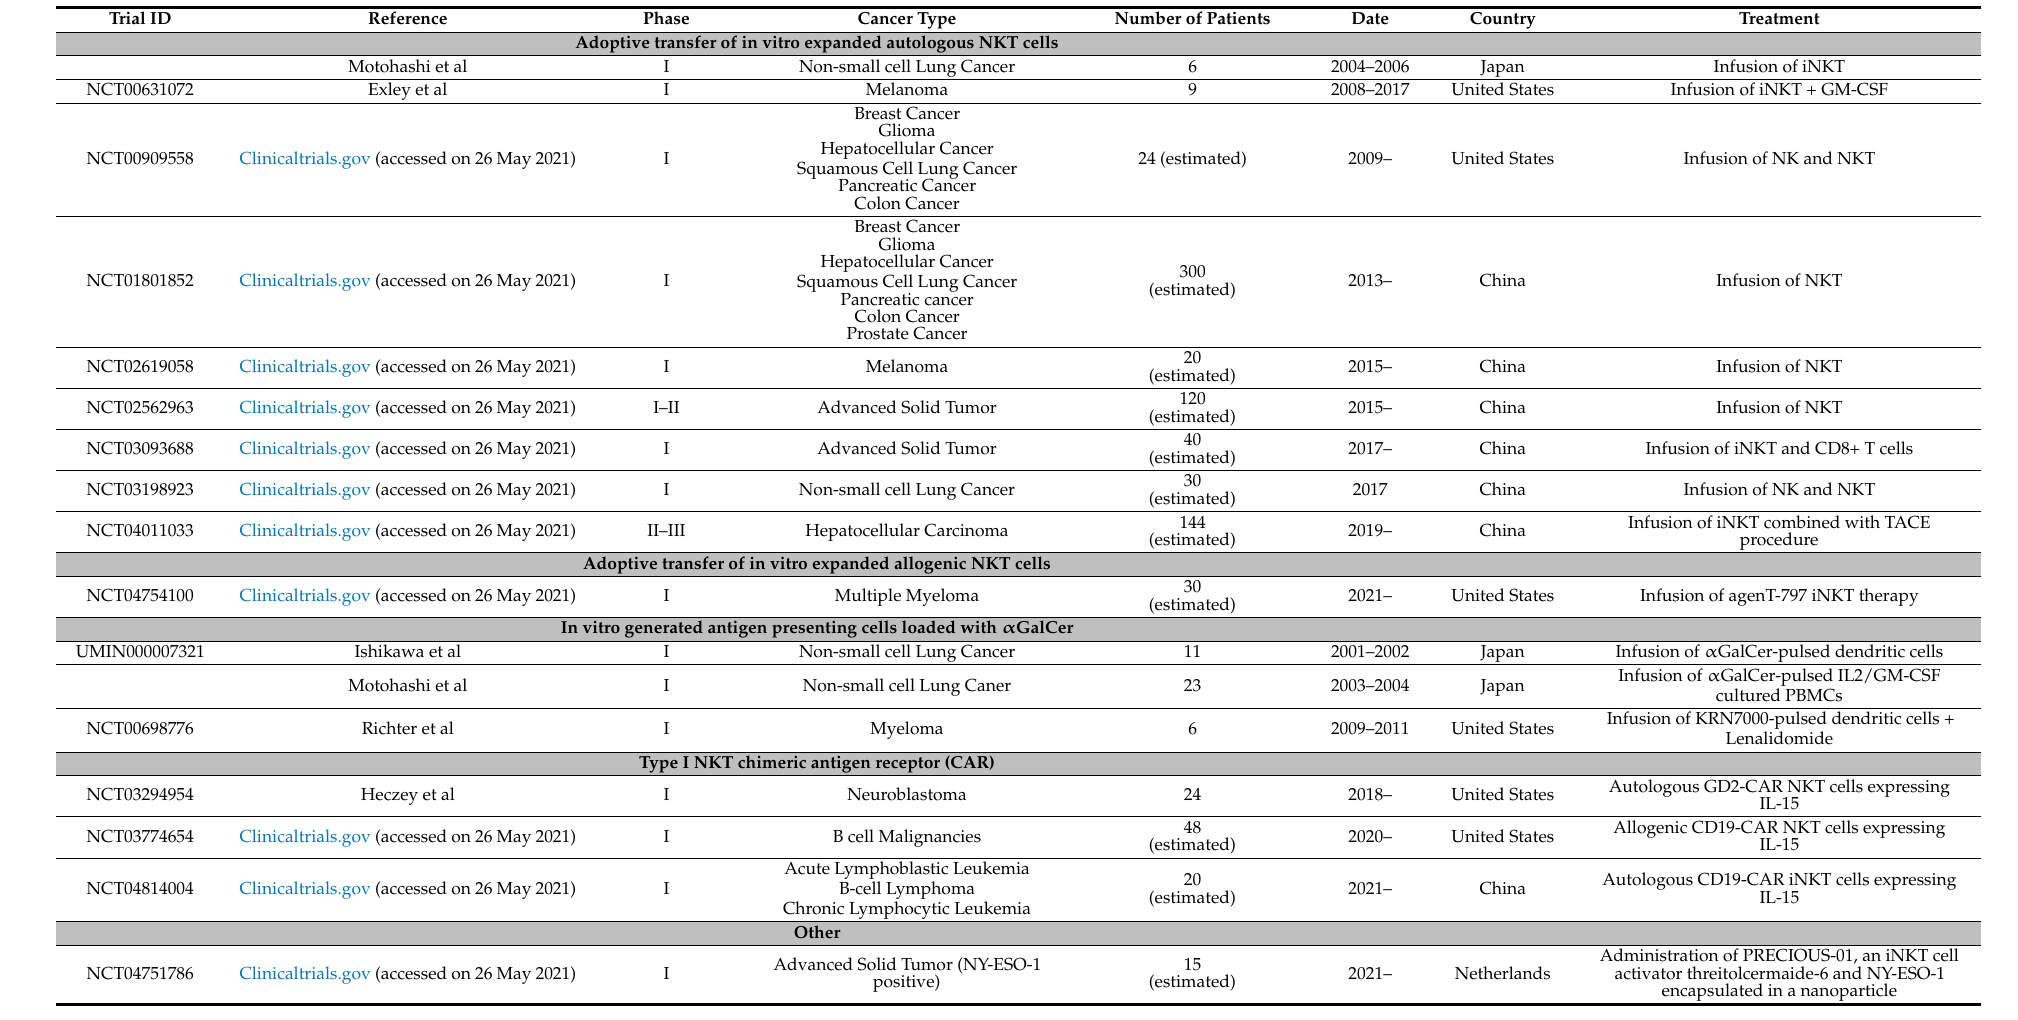
Table 1. Clinical trials using NKT cell-based